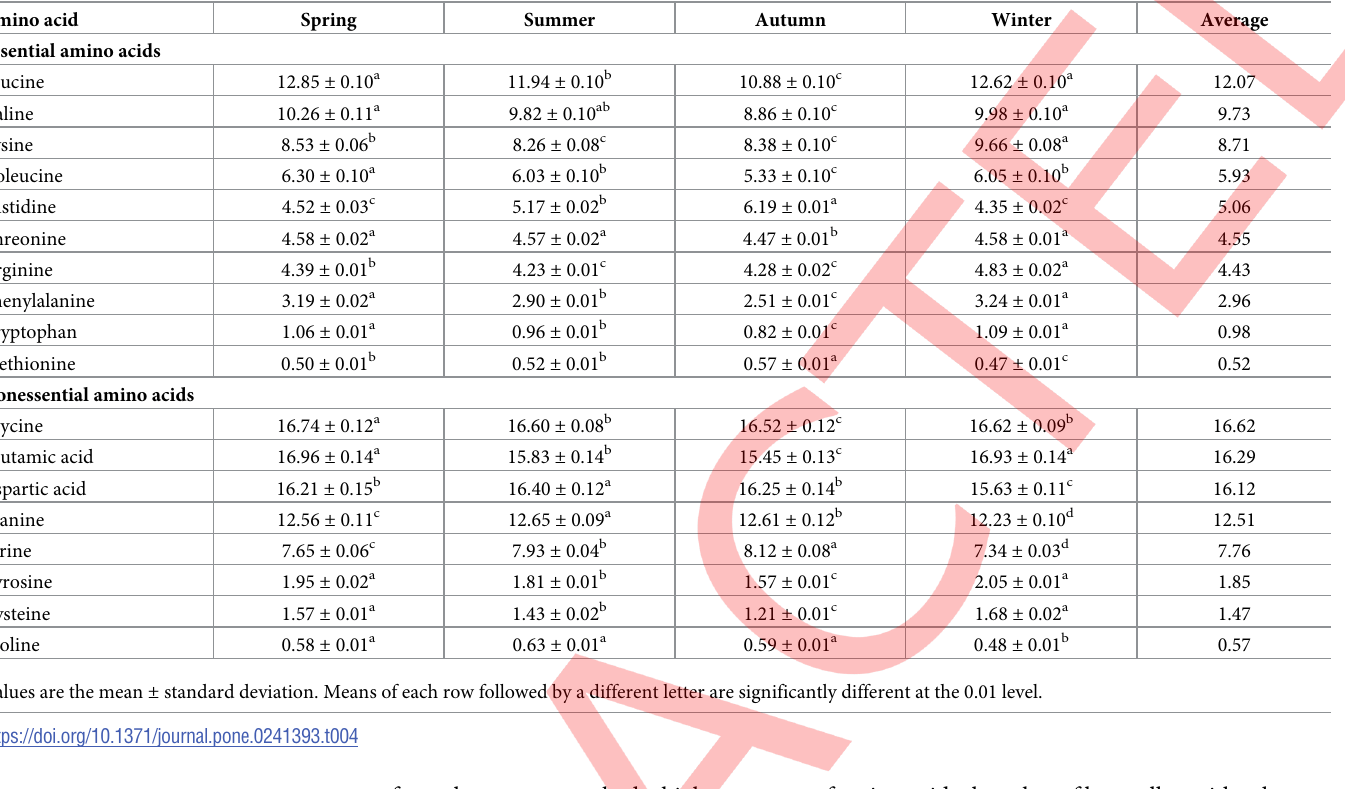
Table 4. Amino acids composition (mg/g DM) of bee pollen.